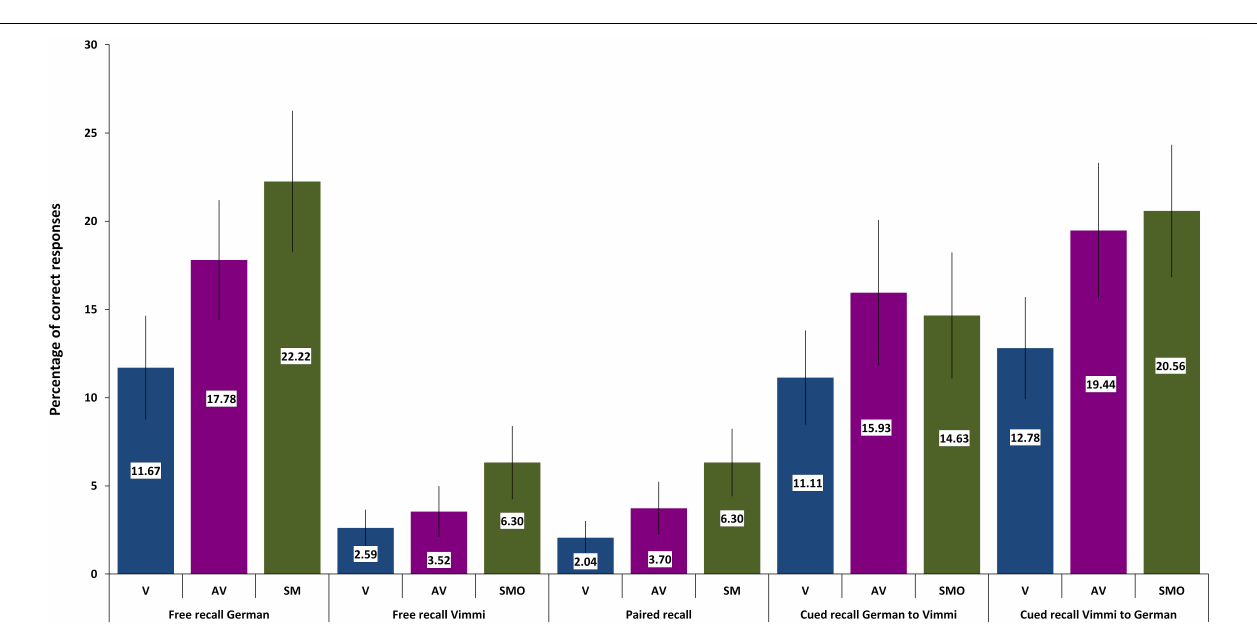
FIGURE 5 | Memory performance in the pencil-to-paper test after ca. 45 days. Error bars indicate one standard